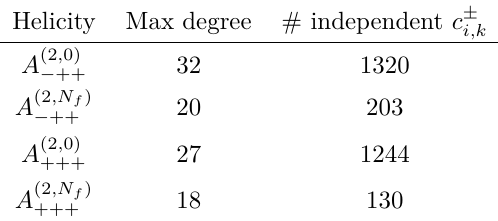
. The column ‘# i,k . i,k